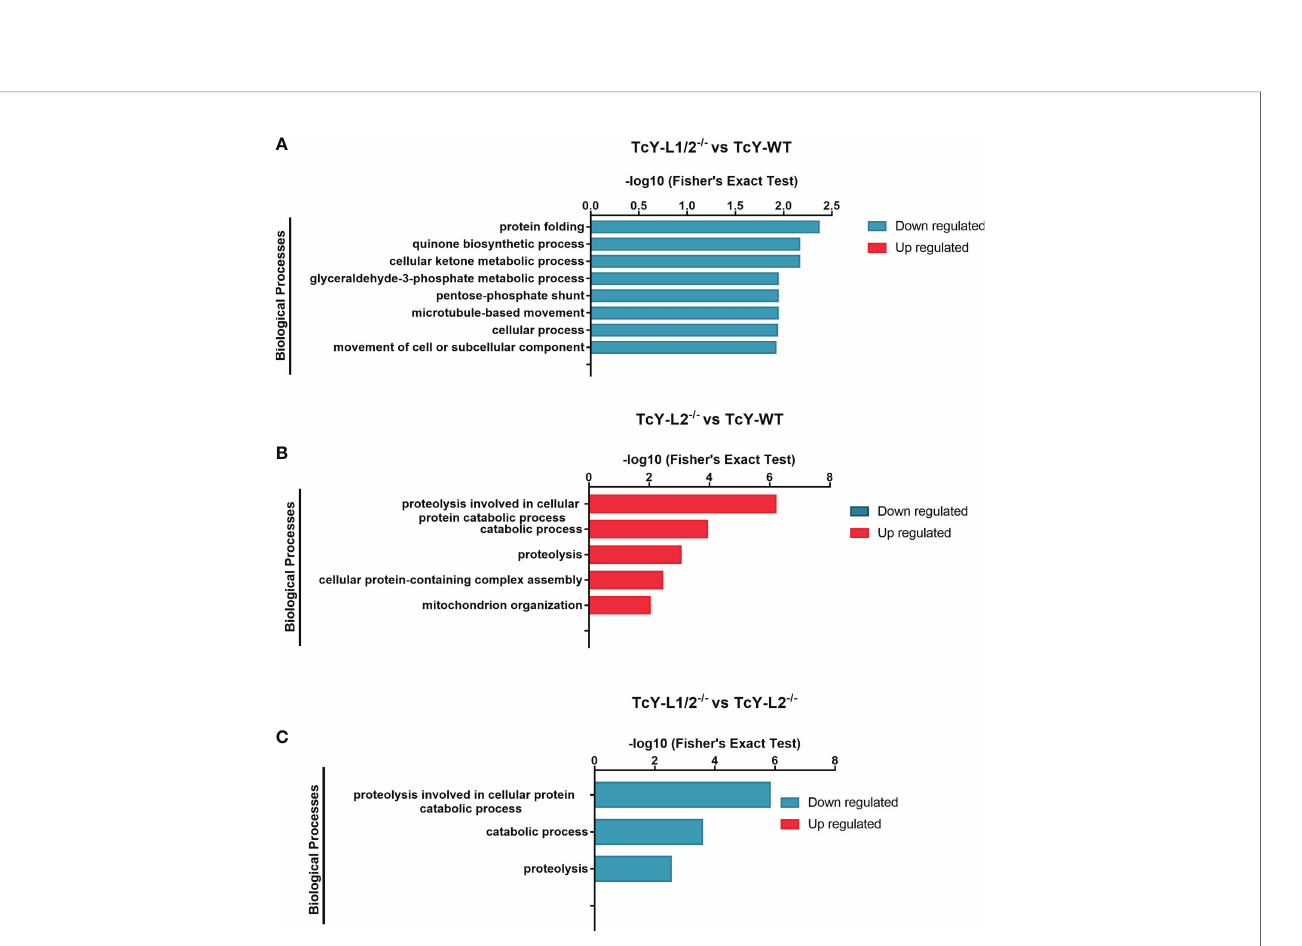
FIGURE 4 | Gene ontology enrichment analysis of biological processes terms in TcY-L1/2 − / − - or TcY-L2 − / − -regulated subproteomes. The graph shows the different biological processes up- or downregulated, based on the differentially expressed proteins of TcY-L1/2 − / − (A) or TcY-L2 − / − (B) compared to TcY-WT proteome and on the differentially expressed proteins of TcY-L1/2 − / − (C) compared to TcY-L2 − / −